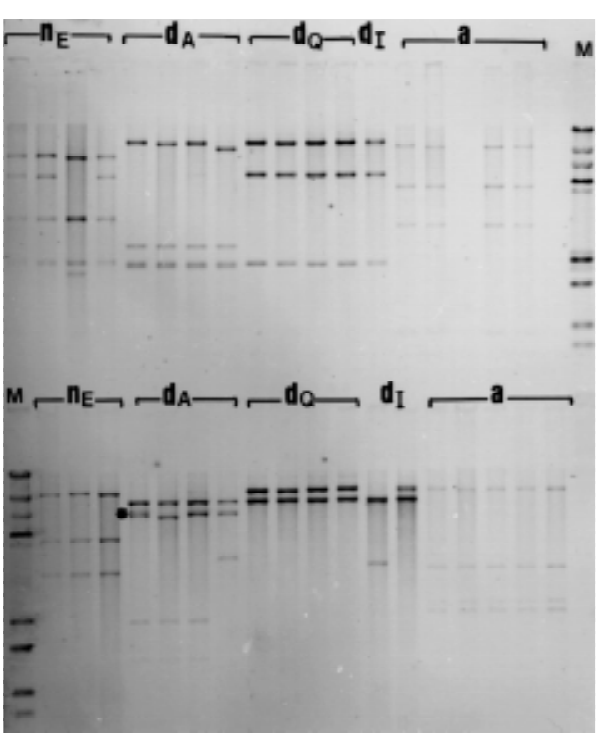
Figure 2 - mtDNA fragment patterns of Tropidurus nanuzae from Extração (n ), T. divaricatus from Alagoado (d E T. amathites (a) using the enzymes Hin dIII (top) and Bcl I (bottom). l DNA ( Hin dIII) and pBR 328 ( Bam HI, Bgl I and Hin fI) were used as molecular size standards (M). (*) Molecular size variation and heteroplasmy.